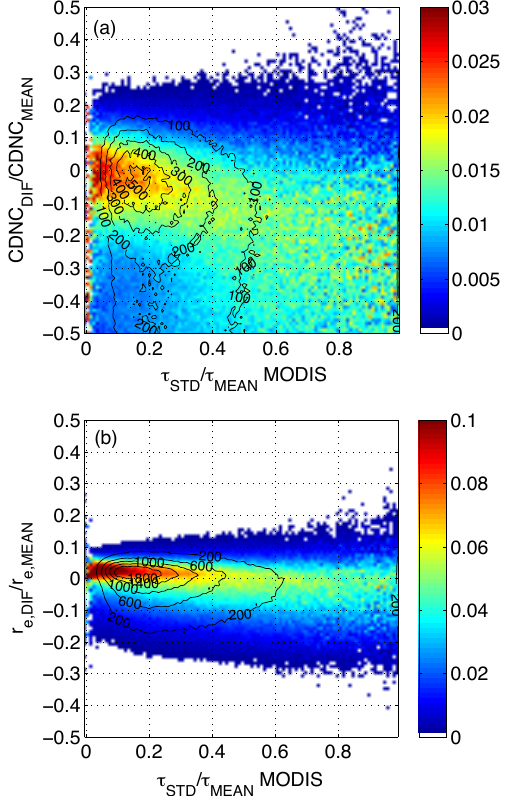
Figure 6. Two-dimensional histograms between relative CDNC dif- ferences and cloud heterogeneity (a) and between relative effective radius differences and cloud heterogeneity (b) . The color bar repre- sents the normalized pixel number of each cloud heterogeneity bin. Solid circle lines are isolines of the pixel number.